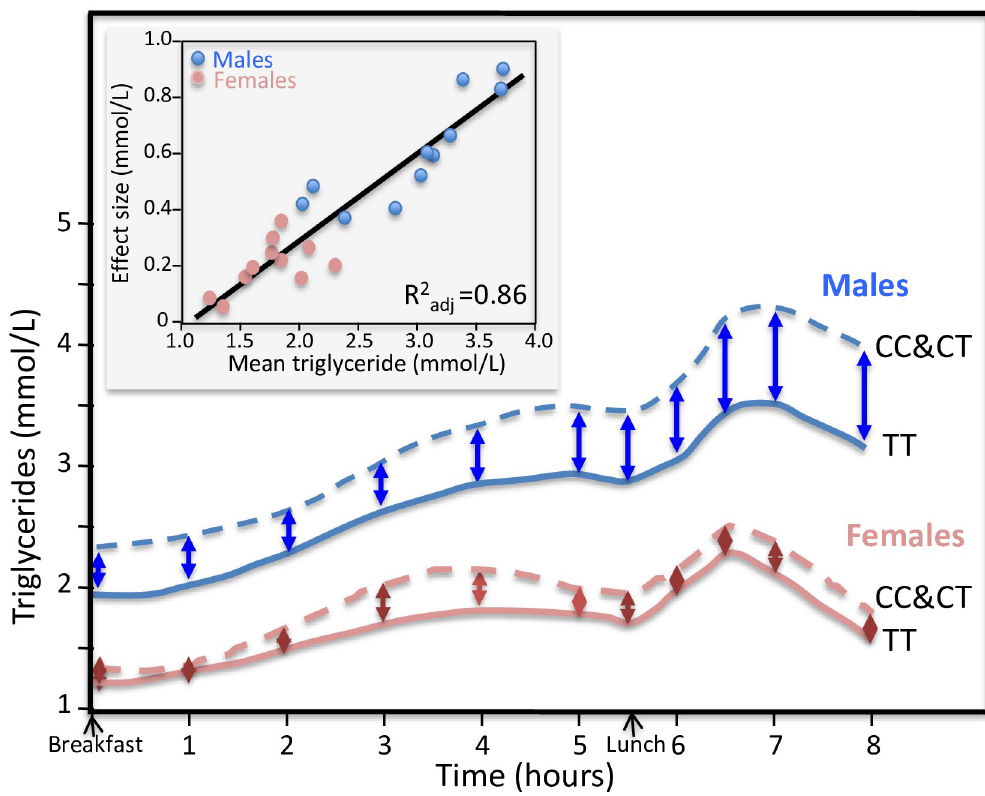
Fig 8. Sex-specific postprandial triglyceride responses in C-carrier vs. TT homozygotes of the APOA5 –1131 T > C polymorphism. Re-rendering of the sex-specific postprandial triglyceride response published by Olano-Martin et al. [88]. The insert presents the quantile-dependent expressivity plot showing that males and females represent largely nonoverlapping triglyceride concentrations over which higher mean triglyceride concentrations predict increasing larger effect size between the C-carriers and TT homozygotes (P = 3.9x10 -10 ).